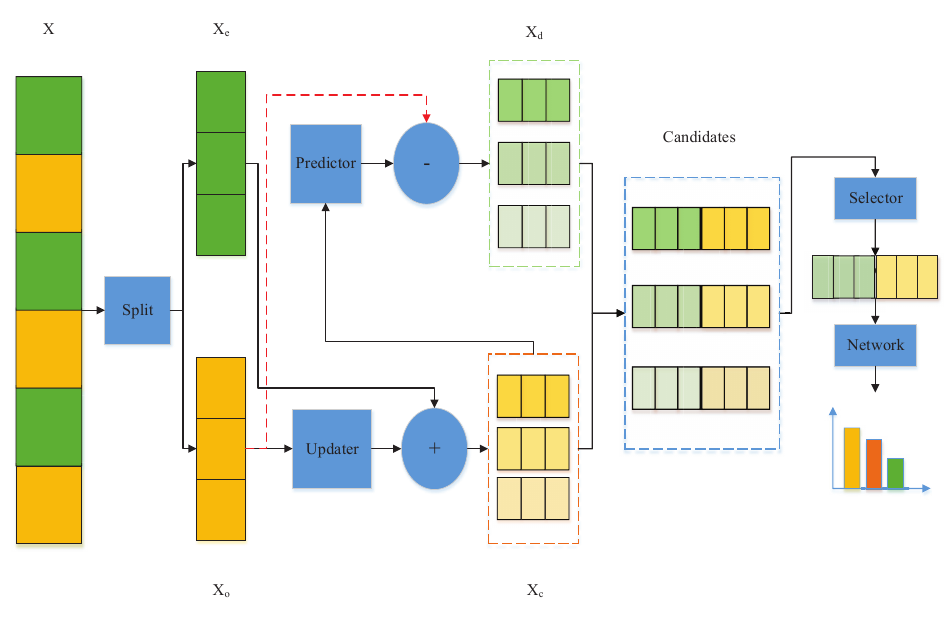
Figure 2. The flowchart of the AMSW-NN.